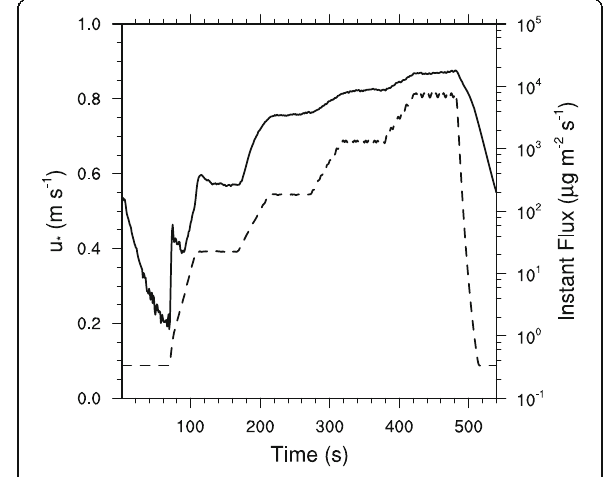
Fig. 6 PI-SWERL test response curve showing no PM 10 supply limitations once threshold friction velocity (u* t ) has been exceeded. The dashed line represents the friction velocity (u*) and the solid line is the instantaneous vertical flux of PM 10 . This test was from the western beach area